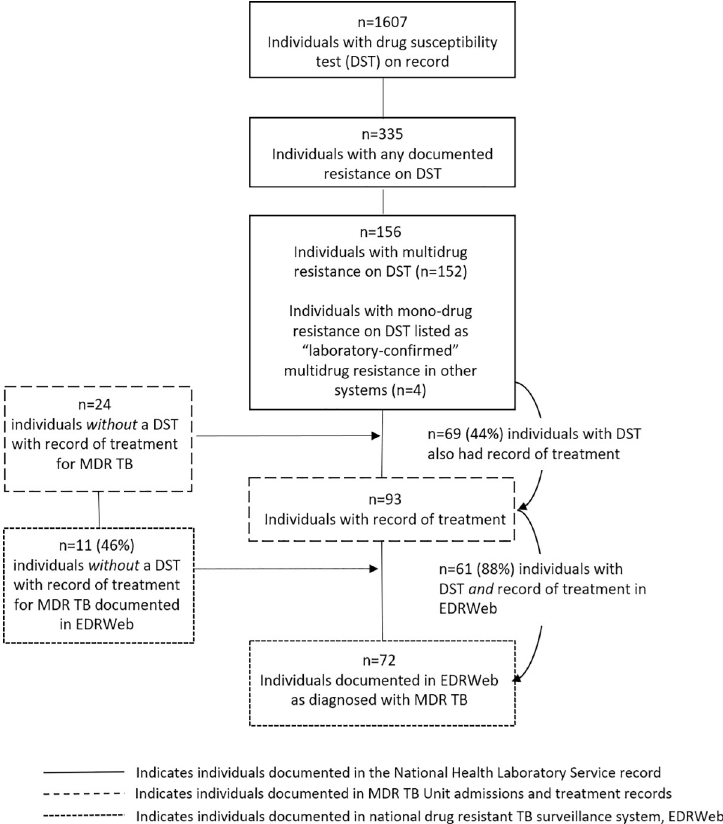
Fig 1. Diagnostic and clinical cascade of care for children ( < 13 years) with any documentation of MDR TB diagnosis as captured by laboratory, hospital, and national disease surveillance systems in three provinces in South Africa,